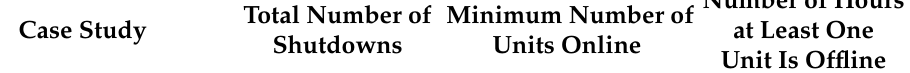
Table 3. Annual nuclear shutdowns